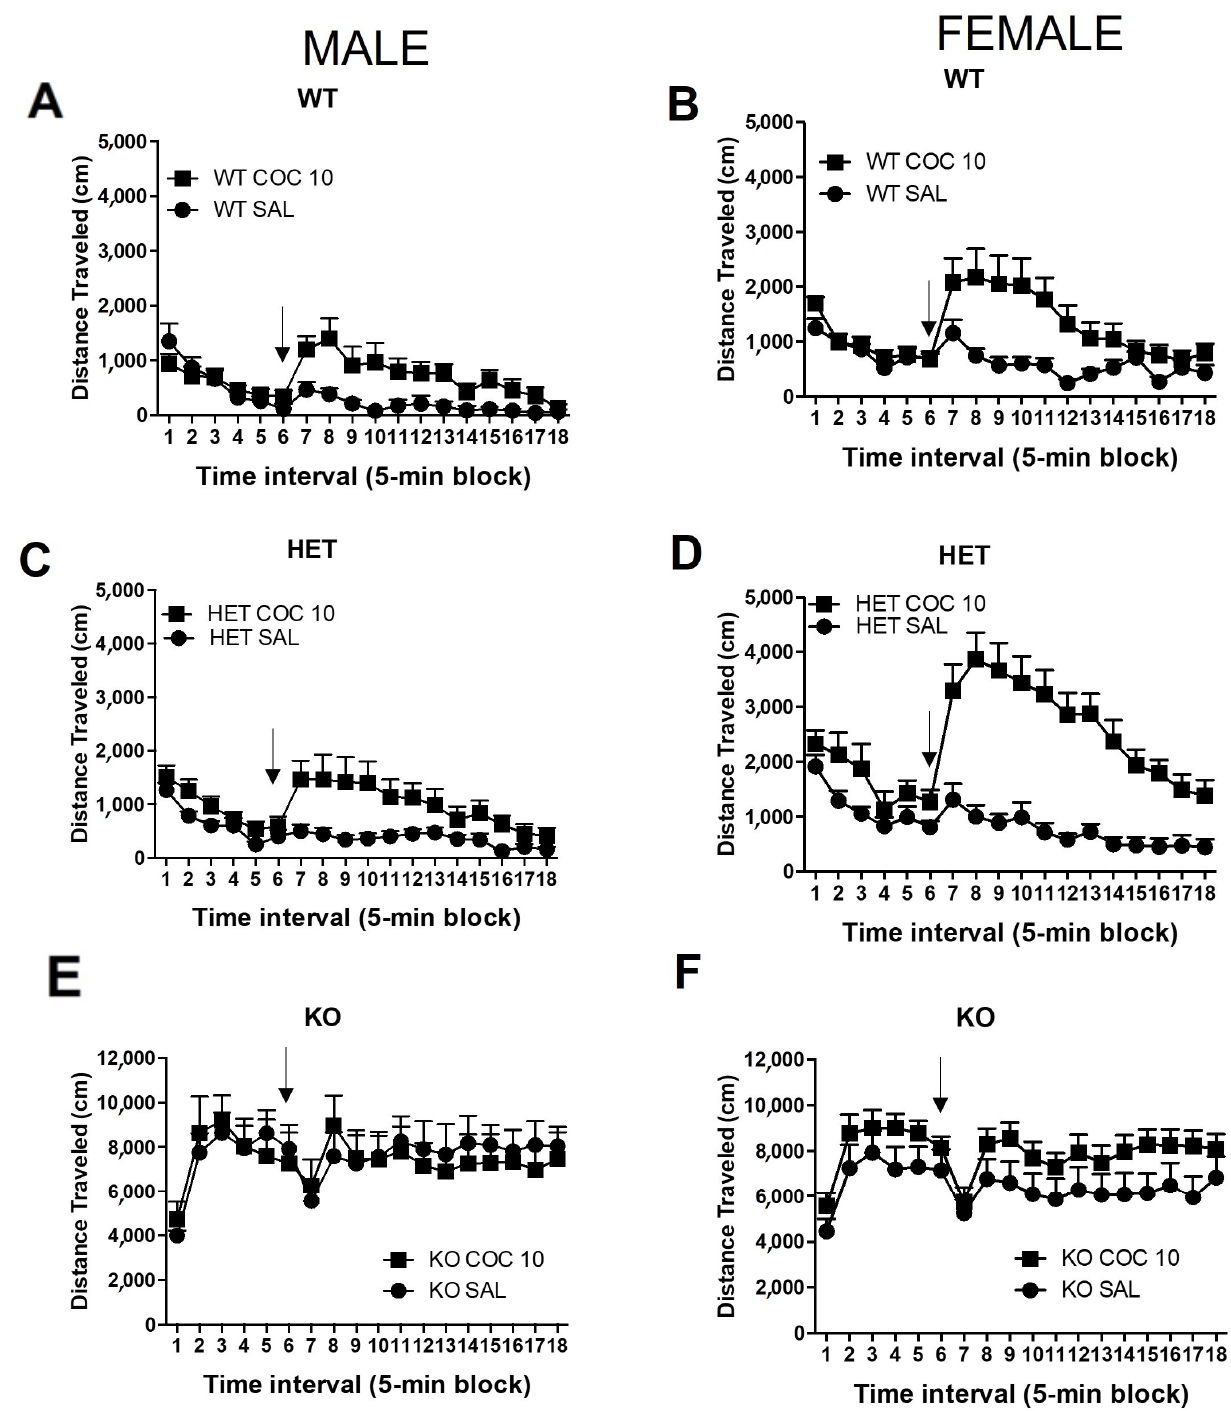
Figure 3. Chronic effect of cocaine on locomotor activity of DAT mutant rats. At PND42, and after repeated daily cocaine injections in the home cage (PND36 to PND41), rats were habituated to the locomotor test chamber for 30 min. Cocaine (0 or 10 mg/kg) was injected (ip) and rats were returned to the chamber and monitored for 60 more min. Time course of locomotor activity of: male ( A ) Wild-type (WT), ( C ) Heterozygous (HET) DAT rat and ( E ) Homozygous (KO) DAT Knockout rats, and female ( B ) Wild-type (WT), ( D ) Heterozygous (HET) DAT rats, and ( F ) Homozygous (KO) DAT Knockout rats. Arrow indicates the time of treatment. Mean ± SEM. (males: WT N = 15, HET N = 36, KO N = 17; females: WT N = 24, HET N = 24, KO N =